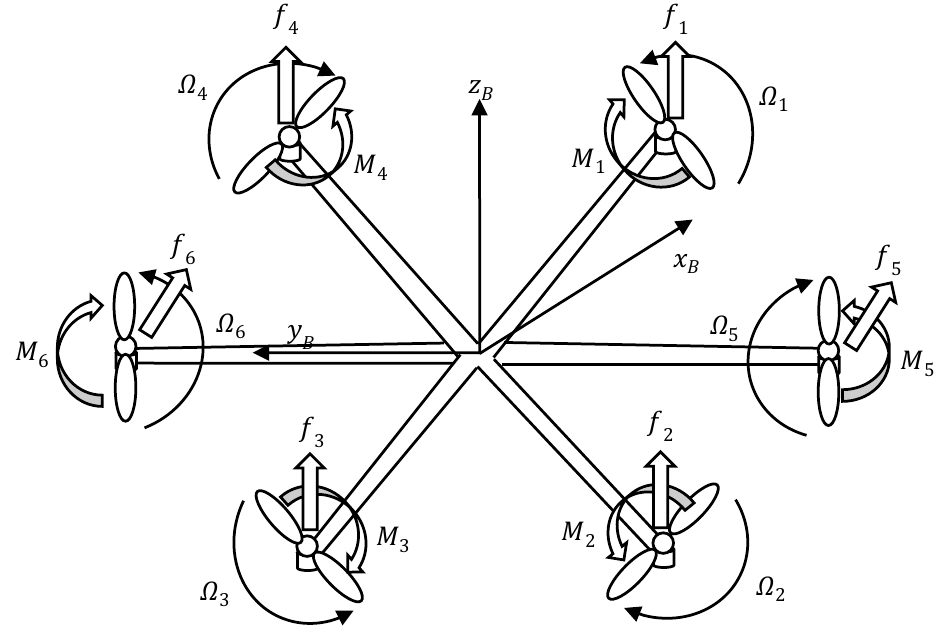
Figure 8. Rotor distribution. f 1 , f 2 , f 3 , f 4 , f 5 , f 6 are the thrust produced by propeller 1, 2, 3, 4, 5, 6. Figure 8. Rotor distribution. 𝑓 1 , 𝑓 2 , 𝑓 3 , 𝑓 4 , 𝑓 5 , 𝑓 6 are the thrust produced by propeller 1, 2, 3, 4, 5, 6. Ω 1 , Ω 2 , Ω 3 , Ω 4 , Ω 5 , Ω 6 presenting the rotating speed and direction. M 1 , M 2 , M 3 , M 4 , M 5 , M 6 present 𝛺 𝛺 𝛺 𝛺 𝛺 𝛺 1 , 2 , 3 , 4 , 5 , 6 presenting the rotating speed and direction. the anti-torque produced by the water, opposite the rotating anti-torque produced by the water, opposite the rotating direction.